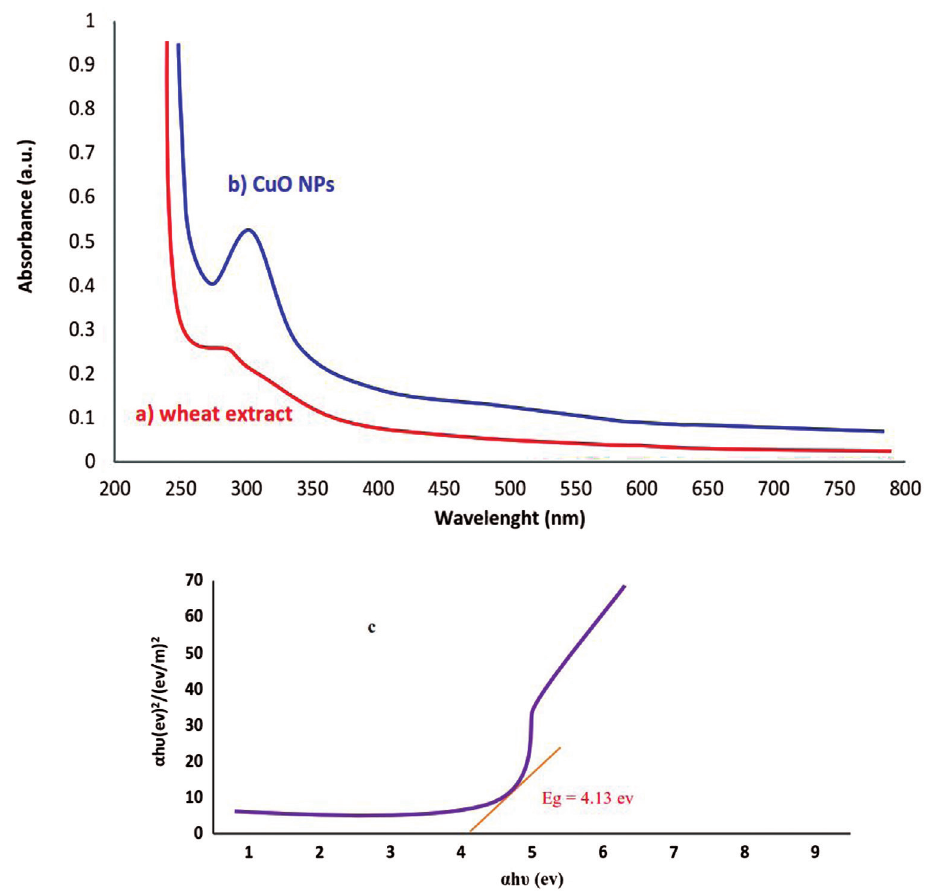
Figure 1: UV–vis spectra of (a) aqueous wheat extract, (b) biofabricated CuO NPs, and (c) Tauc plot of CuO